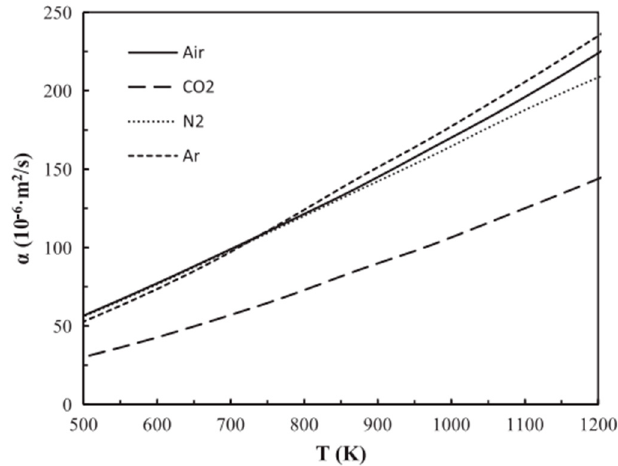
Figure 4. Variation in thermal di ff usivities of CO 2 , N 2 and Ar and air vs. temperature [28]. Adapted with permission from [Zhongshu Wang], Li, W.; Liu, Z.; Wang, Z. Experimental investigation of the thermal and diluent e ff ects of EGR components on combustion and NOx emissions of a turbocharged natural gas SI engine. Energy Convers. Manag. 2014.